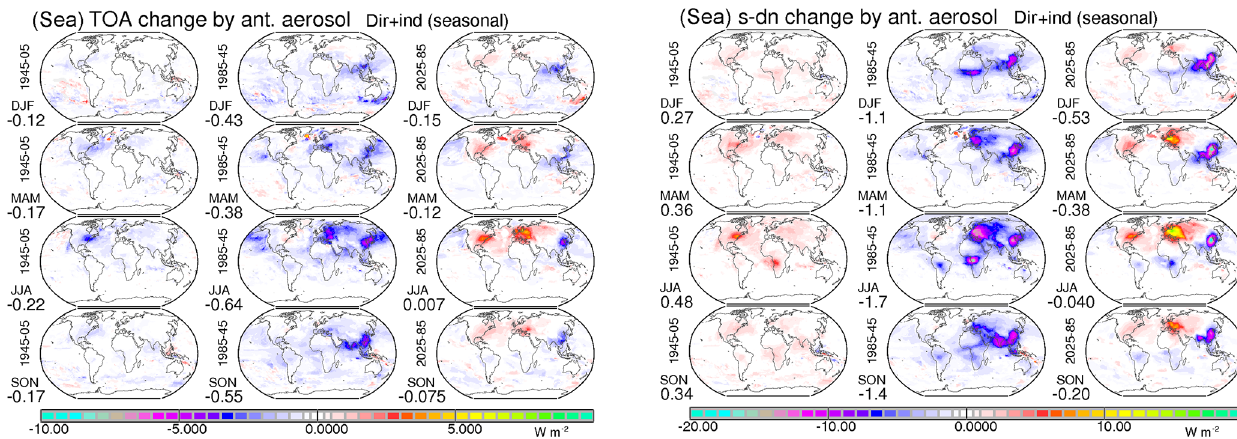
Figure 18. Seasonal changes over 20-year periods (1945–1905, 1985–1945, 2025–1985) in aerosol forcing (left frame) and to solar downward fluxes by anthropogenic aerosol (right frame). Blue colors indicate time periods of increased cooling aerosol or a dimming (decreases to the solar surface fluxes), while red colors indicate time periods of a reduced cooling by aerosol or a brightening (increases the solar surface fluxes). Values below the labels indicate global average changes for the selected time